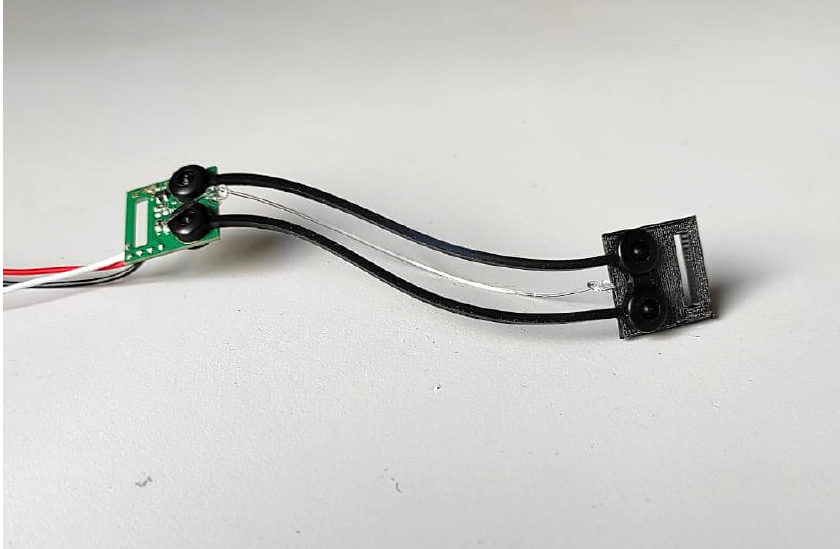
Figure 2. The electroresistive band used in the experimental test.